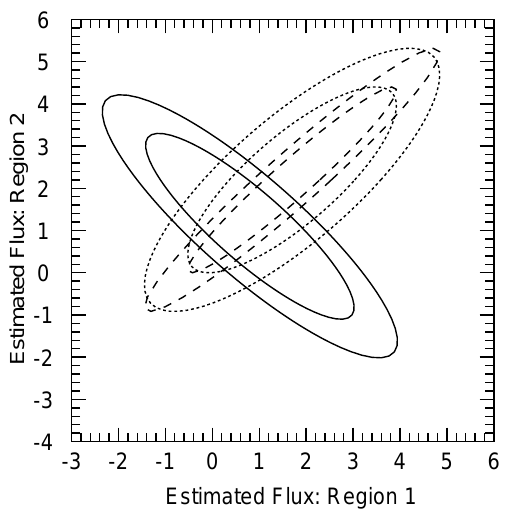
Fig. 2. Schematic of relations between top-down and bottom-up es- timates for two idealised cases of two flux components which differ greatly in the quality of bottom-up